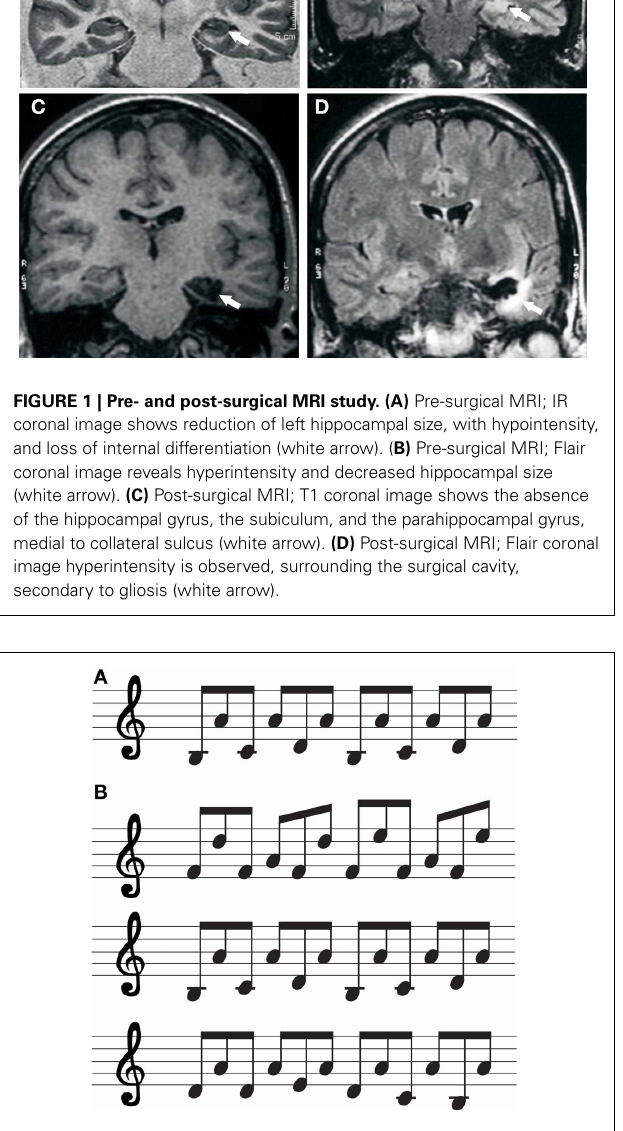
FIGURE 2 | Score-reading task. (A) Musical score excerpt presented during encoding condition (left hemisphere inactivated). (B) Musical scores excerpts presented during retrieval condition (in order to assess left hemisphere